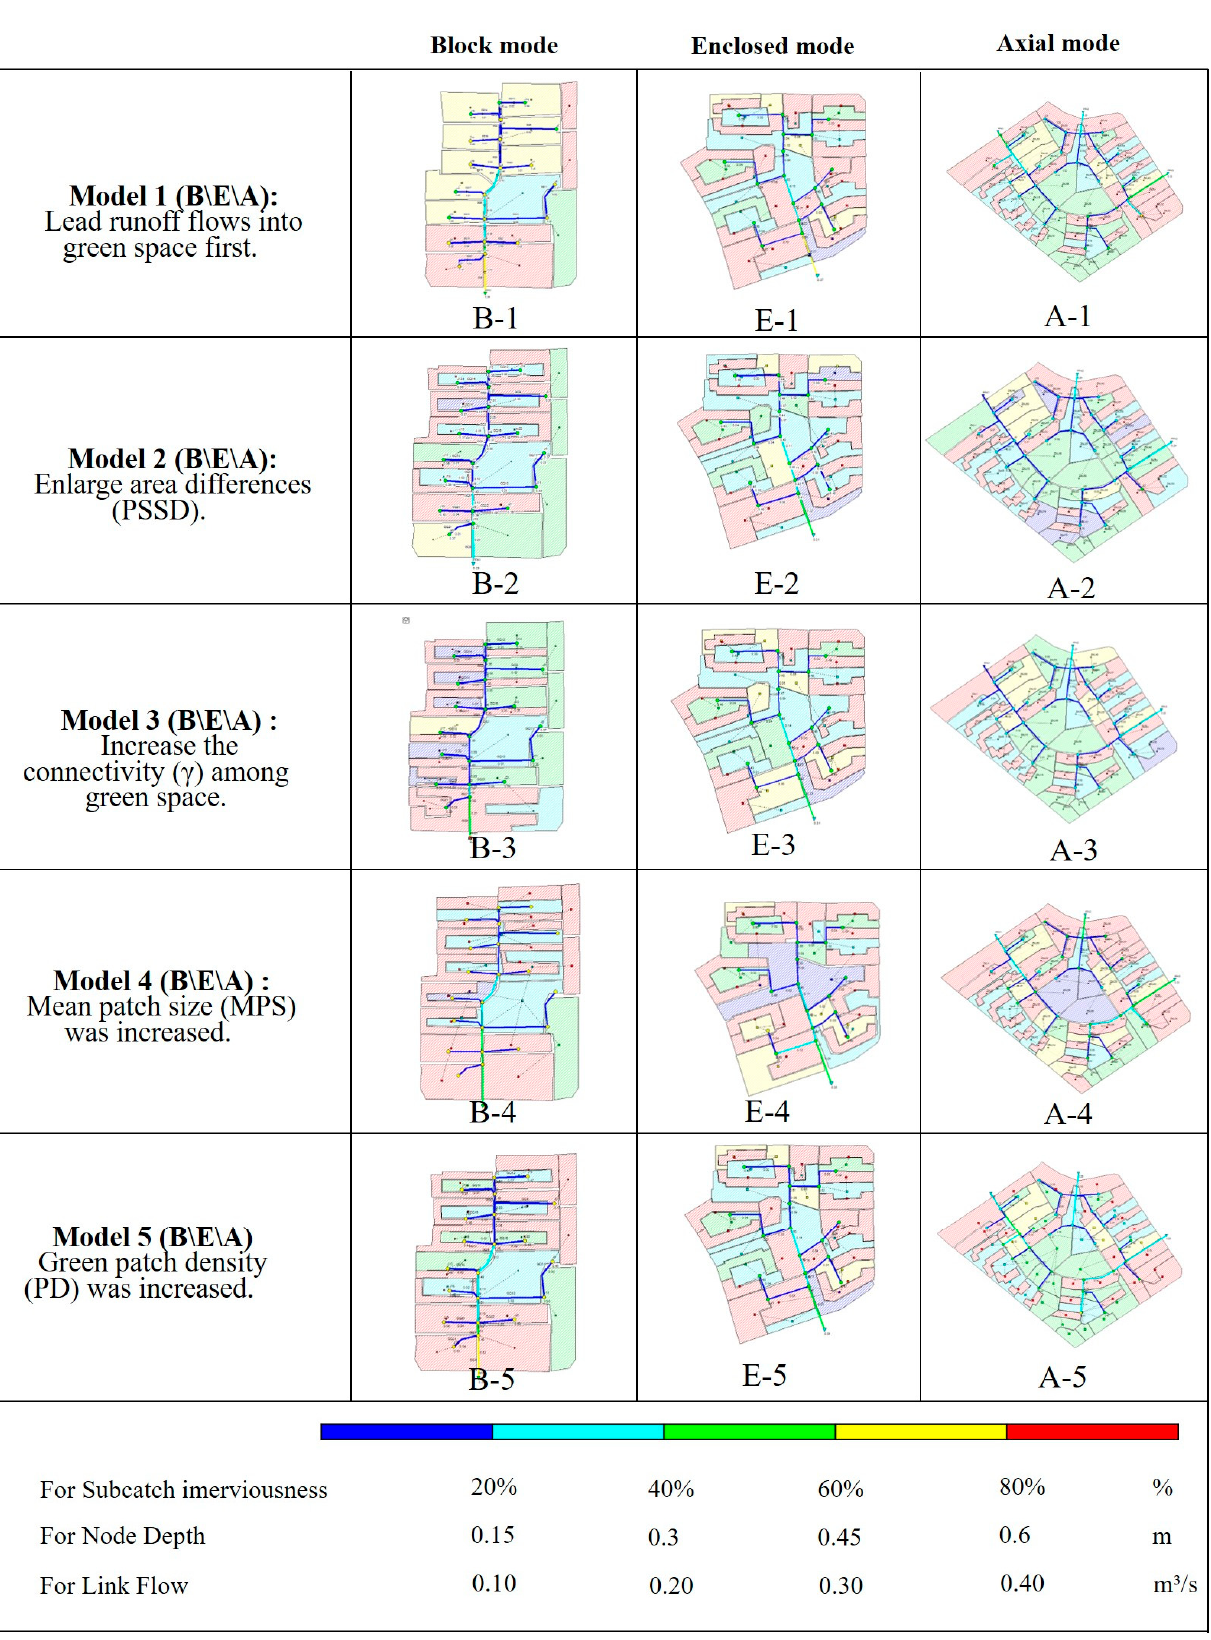
Figure 7. Performance of hydrological process in residential areas with different modes in “runoff peak time” situation.